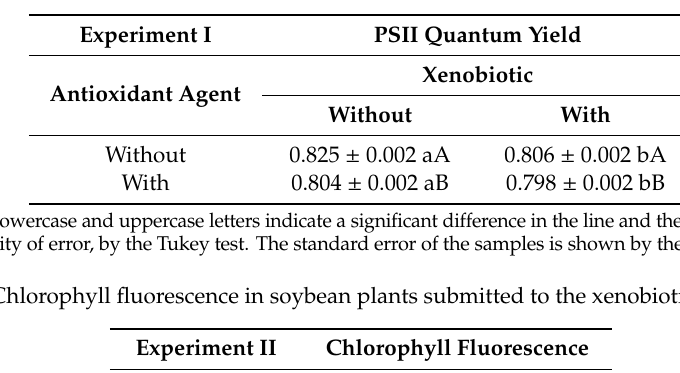
Table 4. PSII quantum yield (mmol CO 2 mmol photons − 1 ) in soybean plants submitted to xenobiotic and antioxidant agent